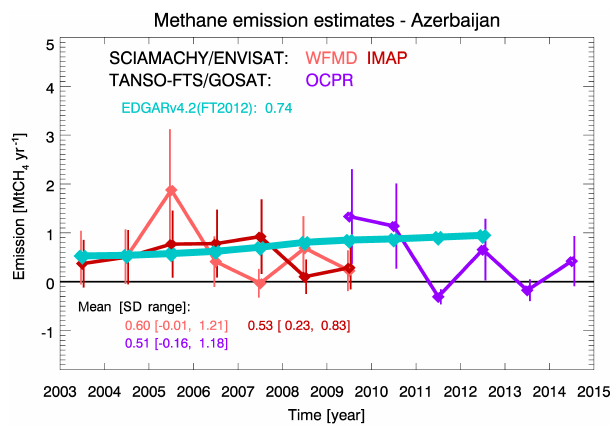
Figure 21. Annual methane emission estimates for Turkmenistan (see also Fig. 19). The blue line shows the EDGAR v4.2 (FT2012) annual emissions for